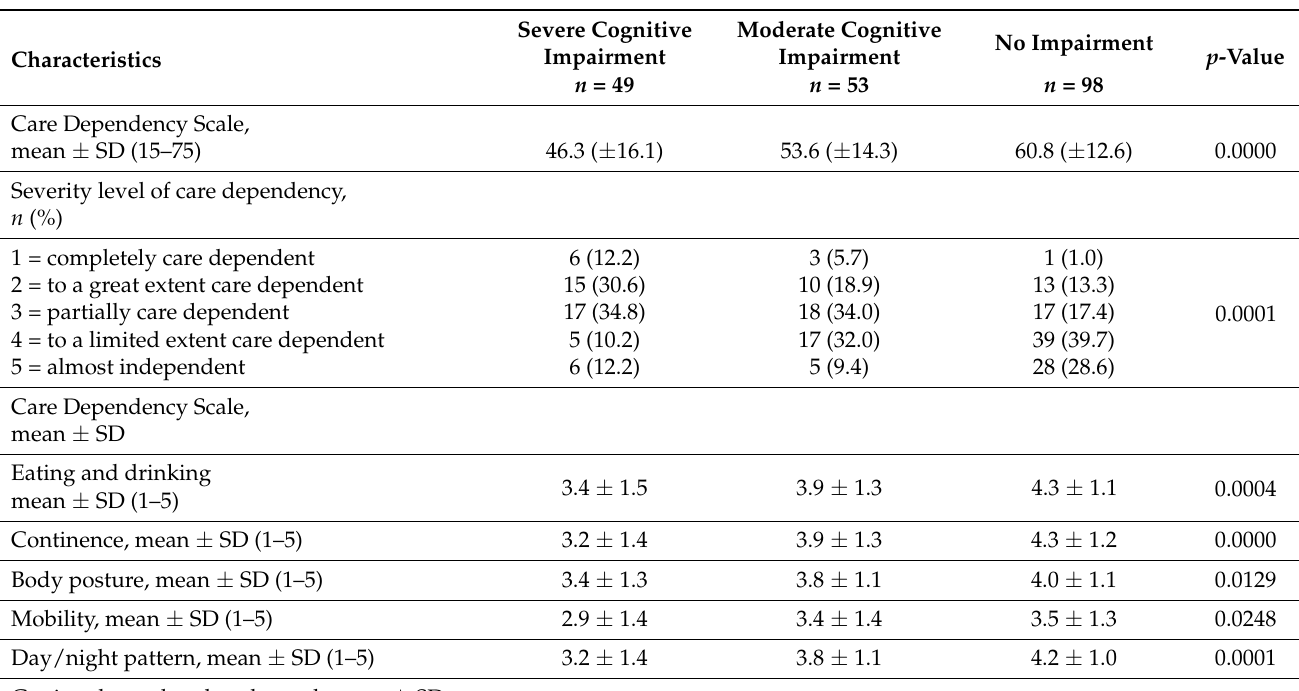
Table 2. The level of care dependency and care needs in groups of different cognitive status ( n =